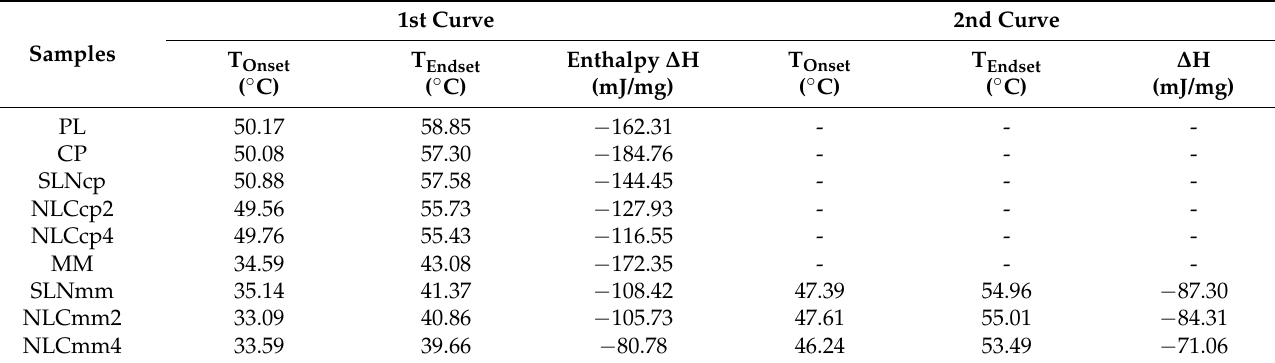
Table 2. DSC analysis of lipid nanoparticles produced with cetyl palmitate and myristyl myristate and their compounds (PL, CP, and